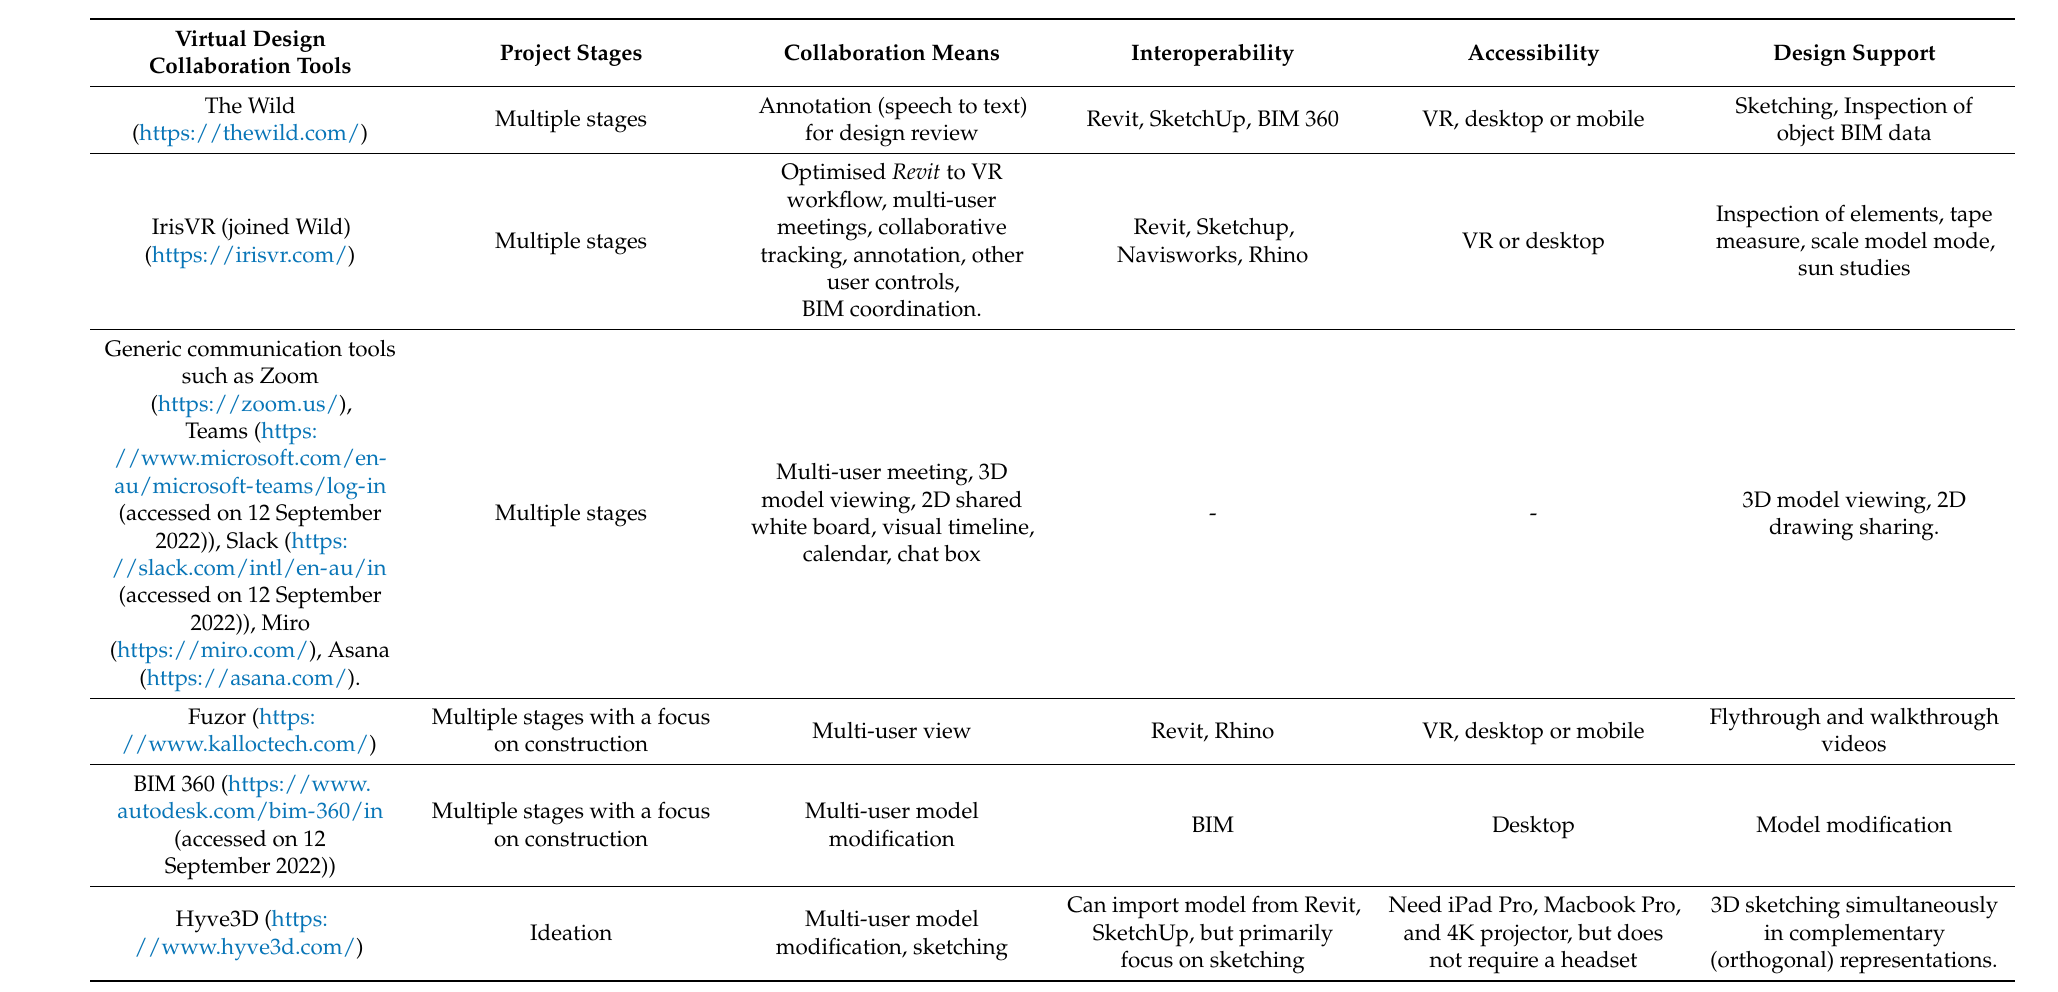
Table 2. Virtual design collaboration tools in the AEC industry (Source: respective official website of each individual